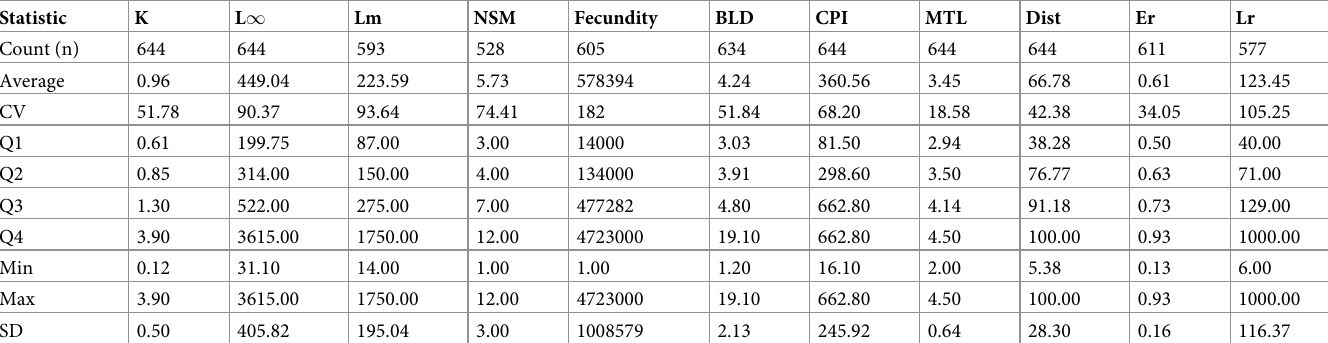
CV–coefficient of variation; Q1-Q4 (Quartile Q1 and Q3 are the first and third quartiles and Q2 is the median value; Q4 is is the maximum value); Min–Minimum; Max–Maximum; SD–Standard deviation. Attributes are K (growth coefficient); L 1 (Asymptotic length); Lm (Length at maturity); NSM (Number of spawning months); BLD (Body length depth); CPI (Coastal productivity index); MTL (Mean trophic level); Dist (Distribution); Er (Exploitation rate) and Lr (Length